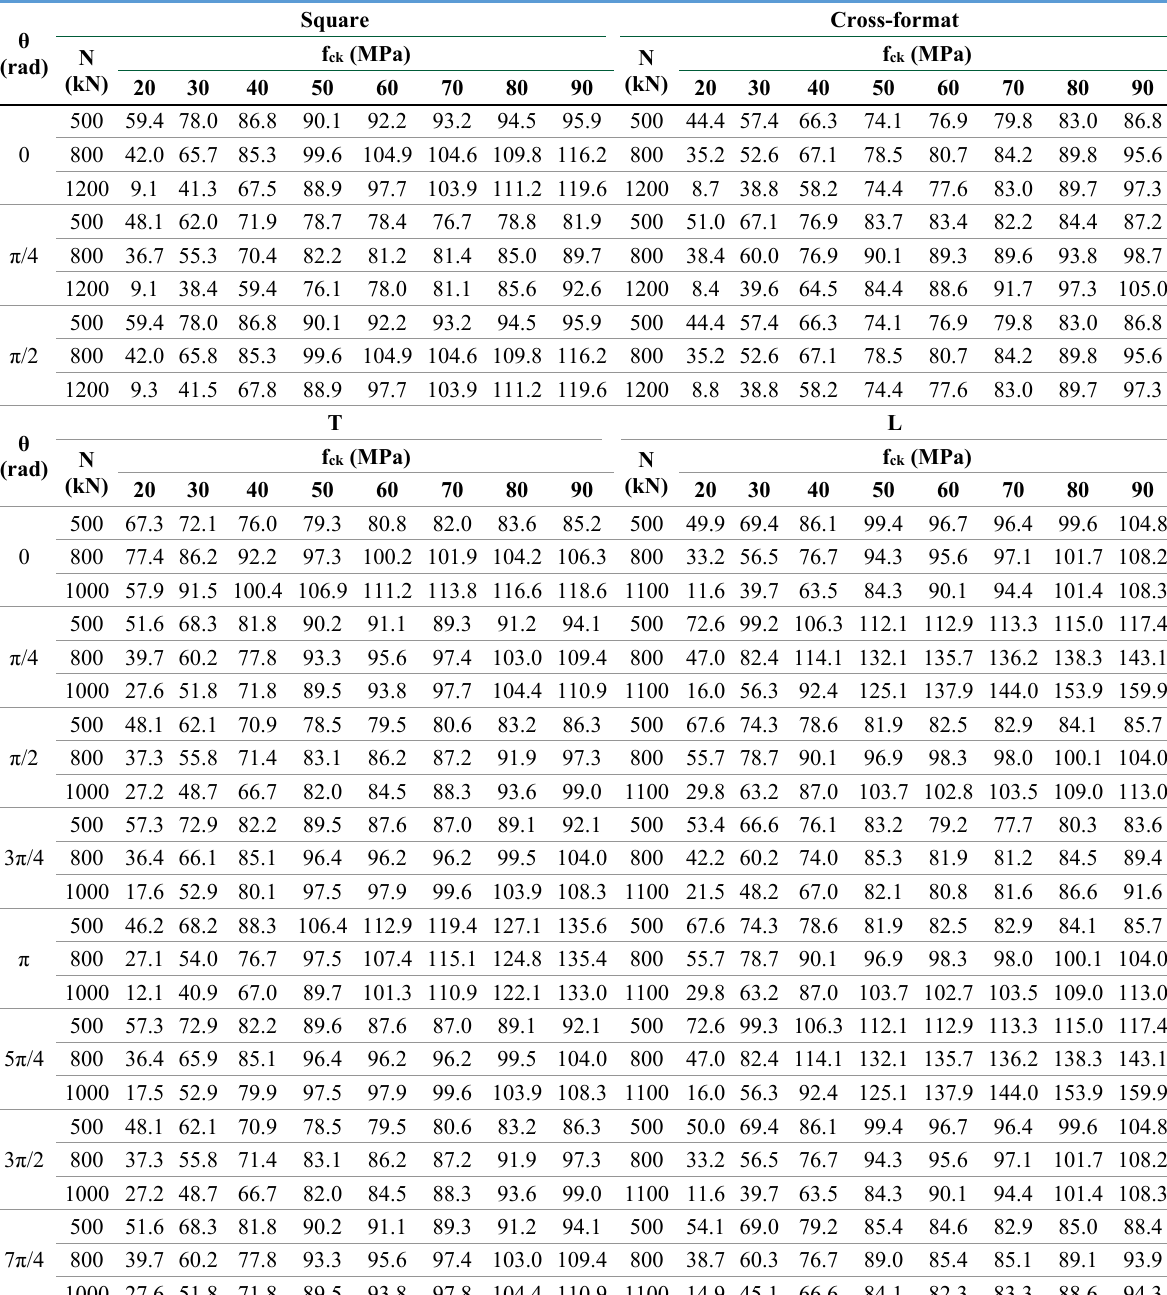
Table 1. Sections flexural strength